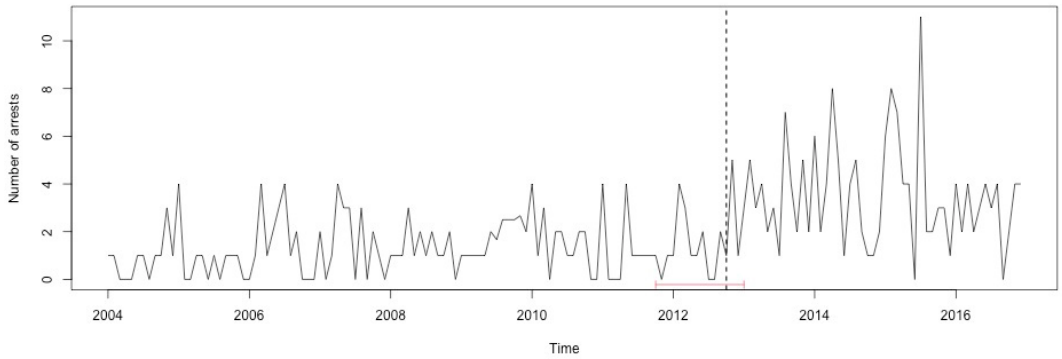
Figure A30. Methamphetamine neighboring countries nationals arrests 2004–2016 in the Czech Republic and structural breaks.